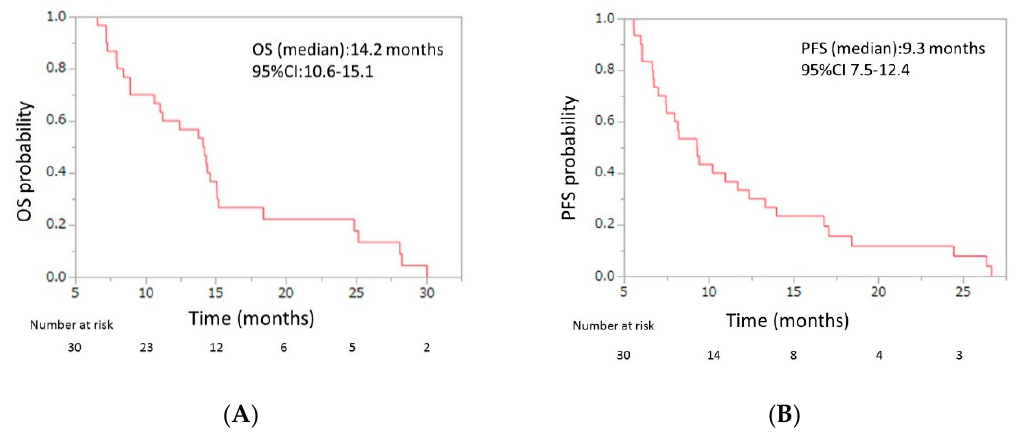
Figure 3. ( A ) Overall survival (OS) and ( B ) progression-free survival (PFS) of patients with unresectable APC who were treated with second-line gemcitabine plus nab-paclitaxel after FOLFIRINOX (FX) failure, from beginning of the first-line FX. The median OS was 14.2 months (95% confidence interval (CI), 10.6–15.1), and the median PFS was 9.3 months (95% CI, 7.5–12.4). APC, advanced pancreatic cancer.